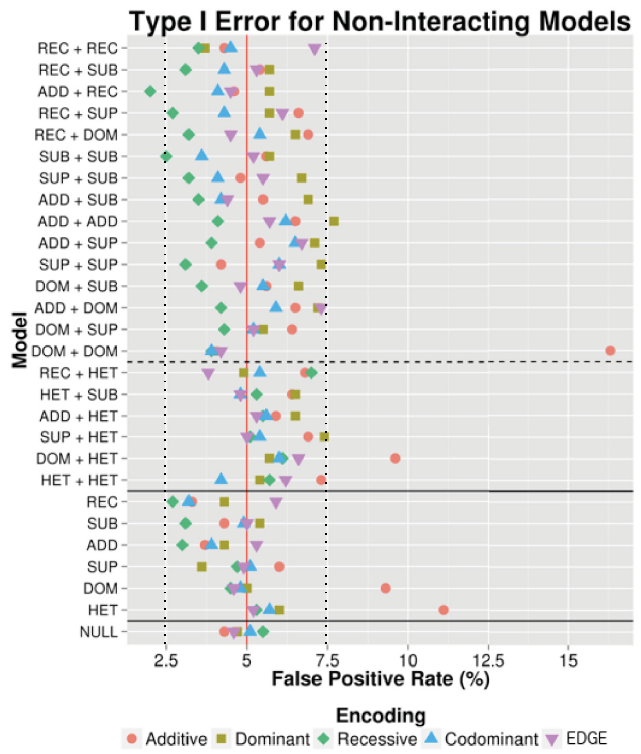
Fig 2. Type I error in simulated main effect and null data. Power to detect two-SNP (above the top solid horizontal line) and One-SNP (below top solid line) main effect simulations are displayed. Null model simulations are shown below the bottom solid horizontal line. The dashed horizontal line separates models involving HET SNPs (below dashed line) from non-HET SNPs (above the dashed lines) because the homozygous genotypes in HET SNPs were simulated to have 0 risk relative to the heterozygous genotype, while the homozygous alternate genotypes for all other SNPs were simulated to have full risk comparted to heterozygotes. Main Effect Only models and null data were simulated (1,000 datasets each) and LRT p-values were calculated using additive (red circle), dominant (yellow square), recessive (green diamond), codominant (blue triangle), and EDGE (purple inverted triangle) encodings to identify the percentage of time each encoding identified a significant interaction when there was none (false positive rate). The red vertical line marks a 5% false positive rate and the dashed black lines mark where the estimated type I error should fall within according to Bradley’s liberal criteria [32]. All SNPs in this figure were simulated with a 30% minor allele